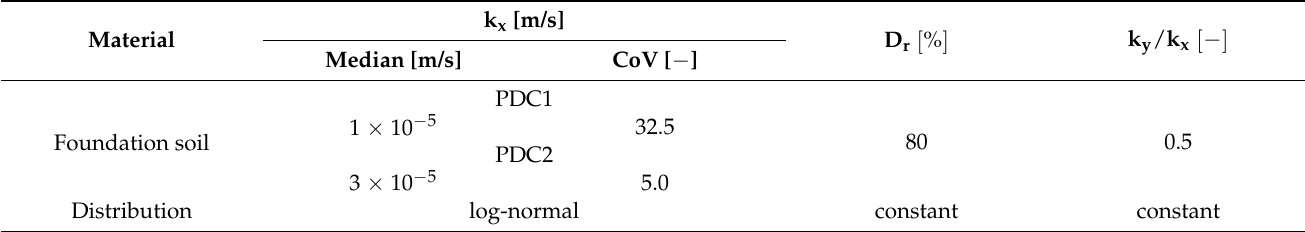
Table 2. Parameters and their statistics used for piping